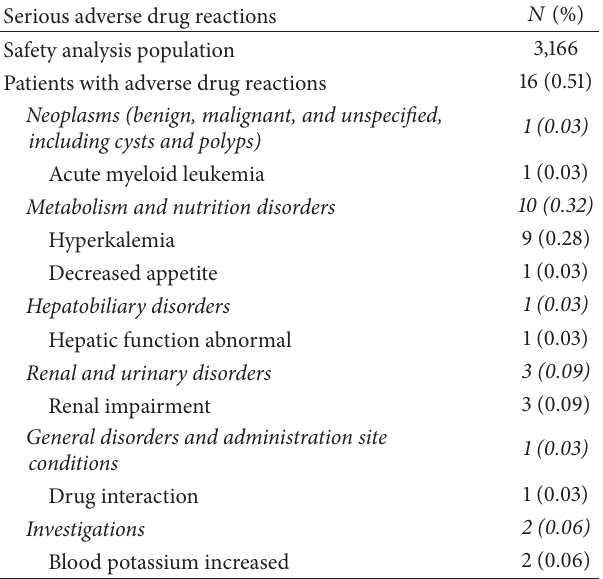
Table 3: Incidence of serious adverse drug